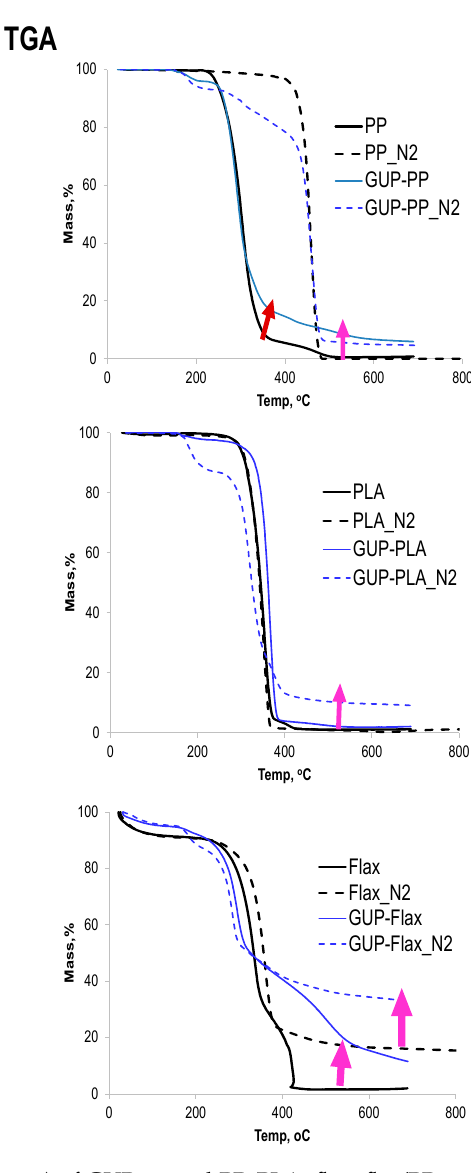
Figure 8. ( a ) PCFC and ( b ) TGA curves (in air and nitrogen) of GUP treated PP, PLA, flax, flax/PP, and flax/PLA .